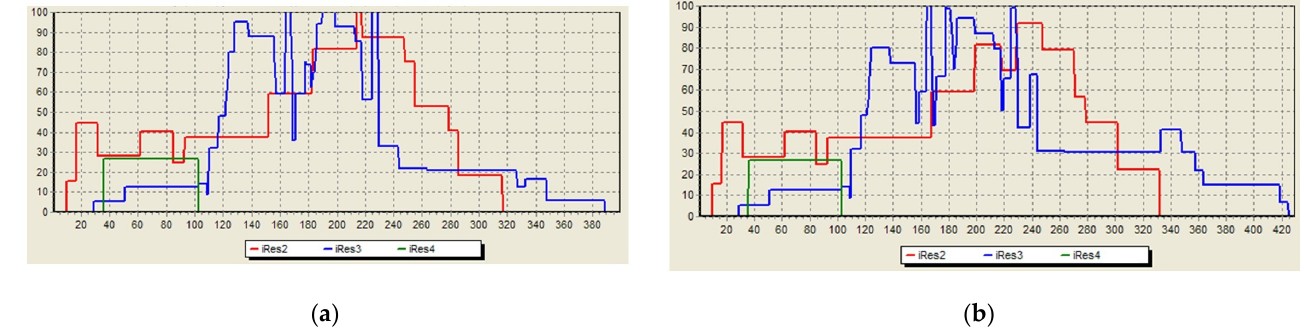
Figure 6. Percentage utilization U of own resources iRes performing the project’s portfolio depending on time: ( a ) Initial schedule; ( b ) Schedule provided by the IH method. Here, iRes2 is a resource with the documentation design competence, iRes3 is a resource with the competence to carry out installation works, and iRes4 is a resource with material supply competence.